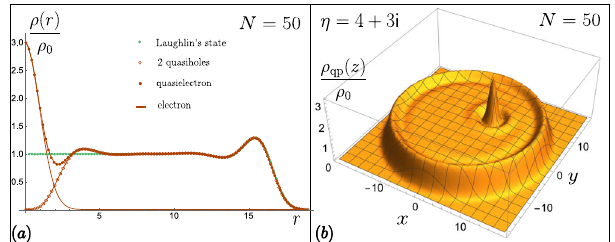
Fig. 2 Fusion mechanism for quasielectrons. a Radial charge density ρ ( r ) (in units of the uniform density ρ ¼ ν ) of a ν = 1/3 Laughlin fl uid (the 0 2 π density of Laughlin ’ s fl uid ρ L ( r ) with N = 50 electrons), two quasiholes e (cid:4) 1 4 j z j 2 , z = x + i y ), and 1 ( N = 49 electrons), one electron (of density 1 2 π quasielectron ( N = 50 electrons) localized at η = 0. The fusion mechanism dictates that the sum of two quasiholes and one electron is identical to one quasielectron. b Quasiparticle localized at η = 4 + 3 i